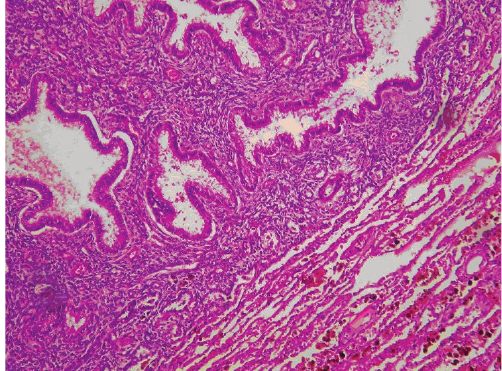
Figure 2: On pathology sections, lung parenchyma including focus of endometriosis containing stroma and glands and hemosiderin- laden macrophages in the adjacent area and hemorrhage sites (HE; ×